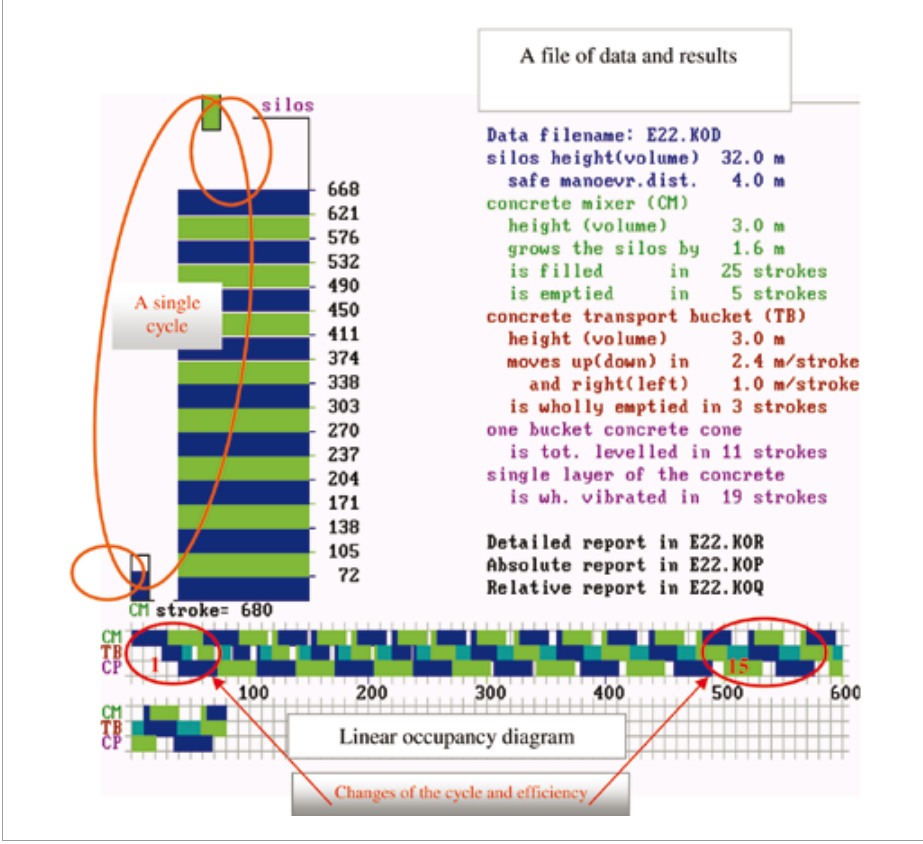
Fig. 4. Full screen produced by SiCE module (simulation captured at stroke number